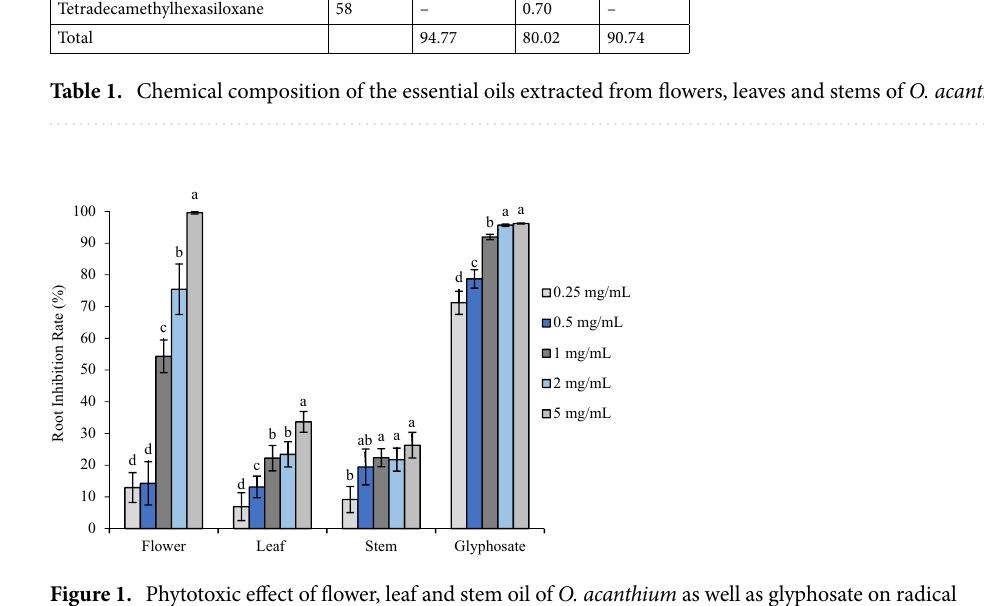
Figure 1. Phytotoxic effect of flower, leaf and stem oil of O. acanthium as well as glyphosate on radical elongation of A. retroflexus ( n = 30). Each value is the mean of three replicates ± SE ( n = 30). Significant difference ( p < 0.05) was represented by different letters.